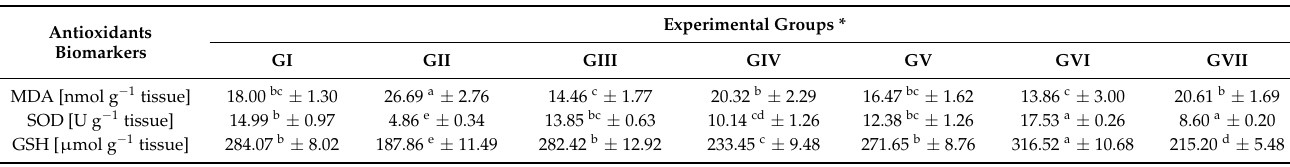
Table 6. SPE, KFE, and KPE and their combination on stomach tissue antioxidants biomarkers of indomethacin-induced gastric ulcer in rats (mean ± SE), n =